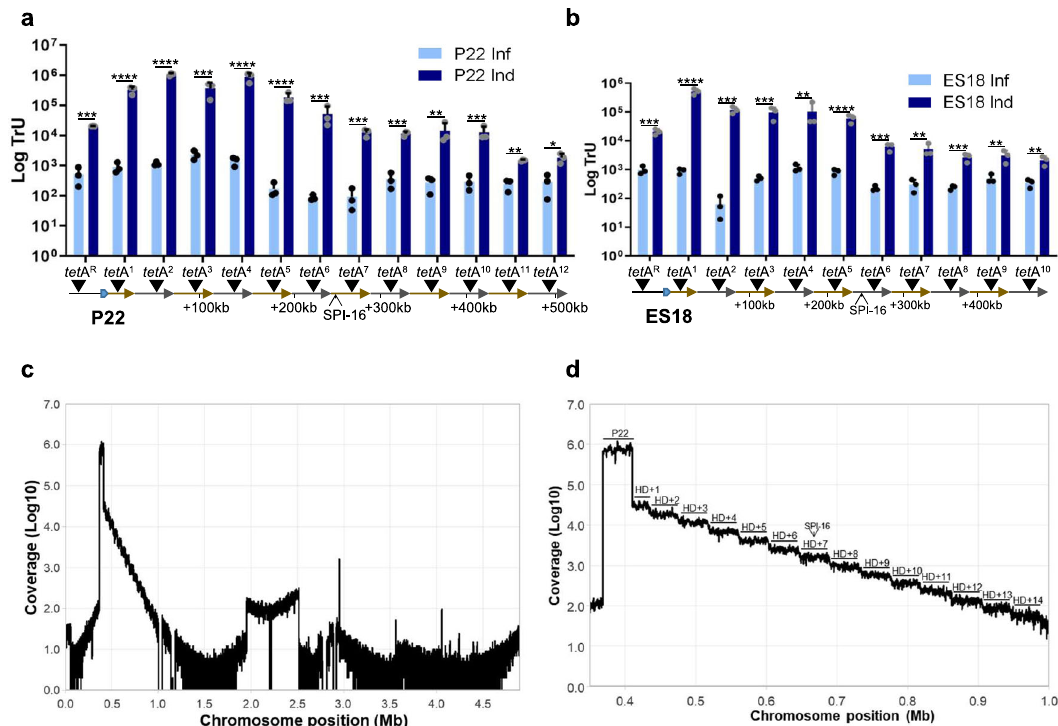
Fig. 4 P22 and ES18 engage in lateral transduction, transferring large metameric spans of the bacterial chromosome at high frequencies. a The transfer of tetracycline ( tet A) markers located upstream ( tet A R ) or downstream of the P22 att B site, in twelve successive capsid headfuls ( tet A ” n ” ), was tested following P22 prophage induction (Ind) or P22 infection (Inf). b The transfer of tet A markers located upstream ( tet A R ) or downstream of the P22 att B site, in ten successive capsid headfuls ( tet A ” n ” ), was tested after ES18 induction or ES18 infection. c A P22 lysogen was mitomycin C-induced and the resulting phage particles puri fi ed. The DNA from the phage particles was extracted and sequenced. The coverage of chromosomal DNA is represented. d Zoom of the region encompassing lateral transduction is visualized, displaying a successive ‘ stepdown ’ pattern in DNA packaging ef fi ciency for each consecutive headful. Transduction units (TrU) per milliliter were normalized by PFU per milliliter and represented as the log TrU of an average phage titer (1 × 10 9 PFU). Error bars indicate standard deviation from the mean of three independent experiments. For all panels, values are means ( n = 3 independent samples). An unpaired two-sided t test was performed to compare mean differences between infection and induction in each marker. Adjusted p values were as follows: ns > 0.05; * p ≤ 0.05; ** p ≤ 0.01; *** p ≤ 0.001; **** p ≤ 0.0001. The exact statistical values for each of the conditions tested are listed on Table